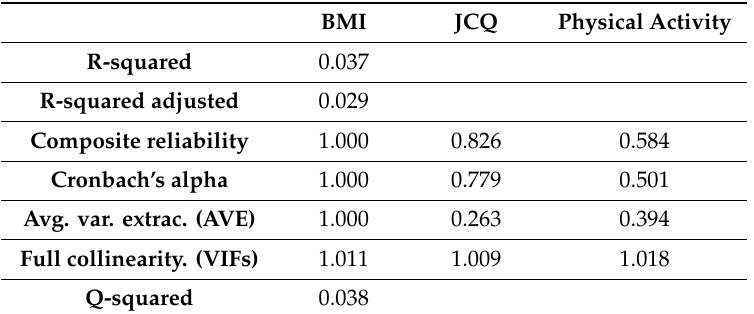
Table 9. Model 3. Latent variable coe ffi cients for the relationships between work stress, physical activity, and